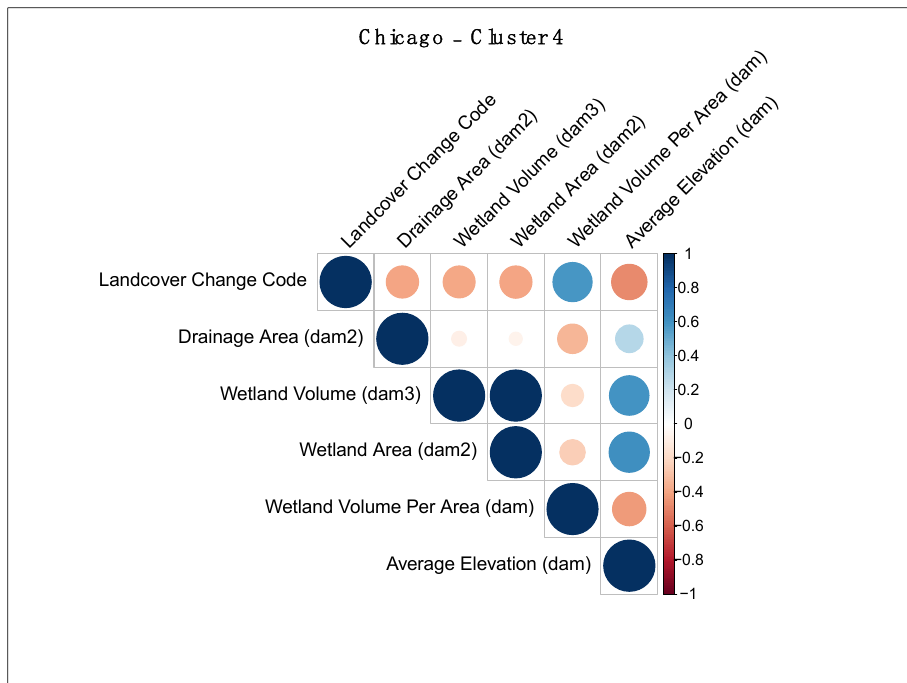
Figure 12. Chicago cluster 4 correlation matrix.